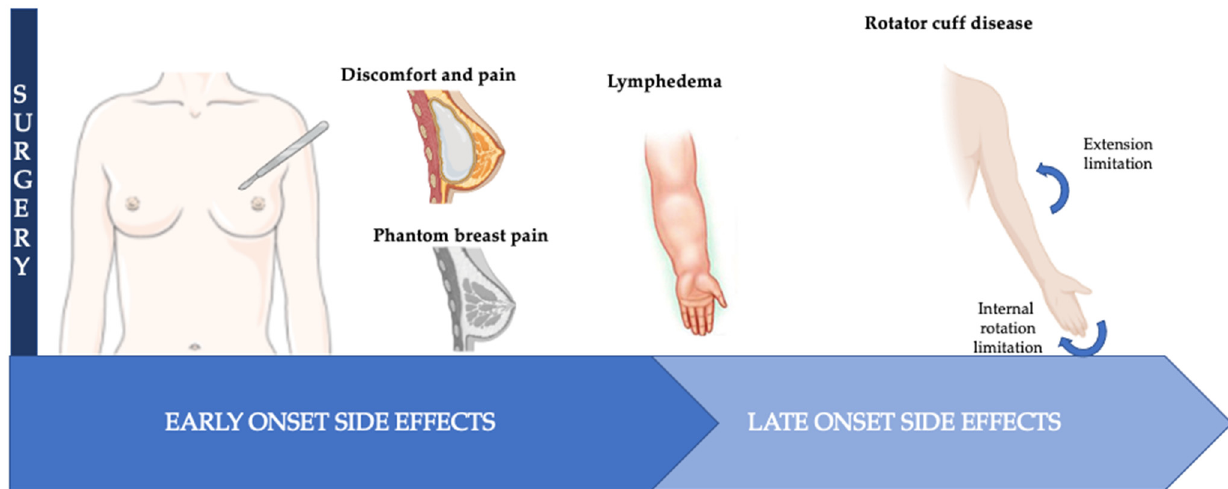
Figure 1. most important side effects of surgery and timing of